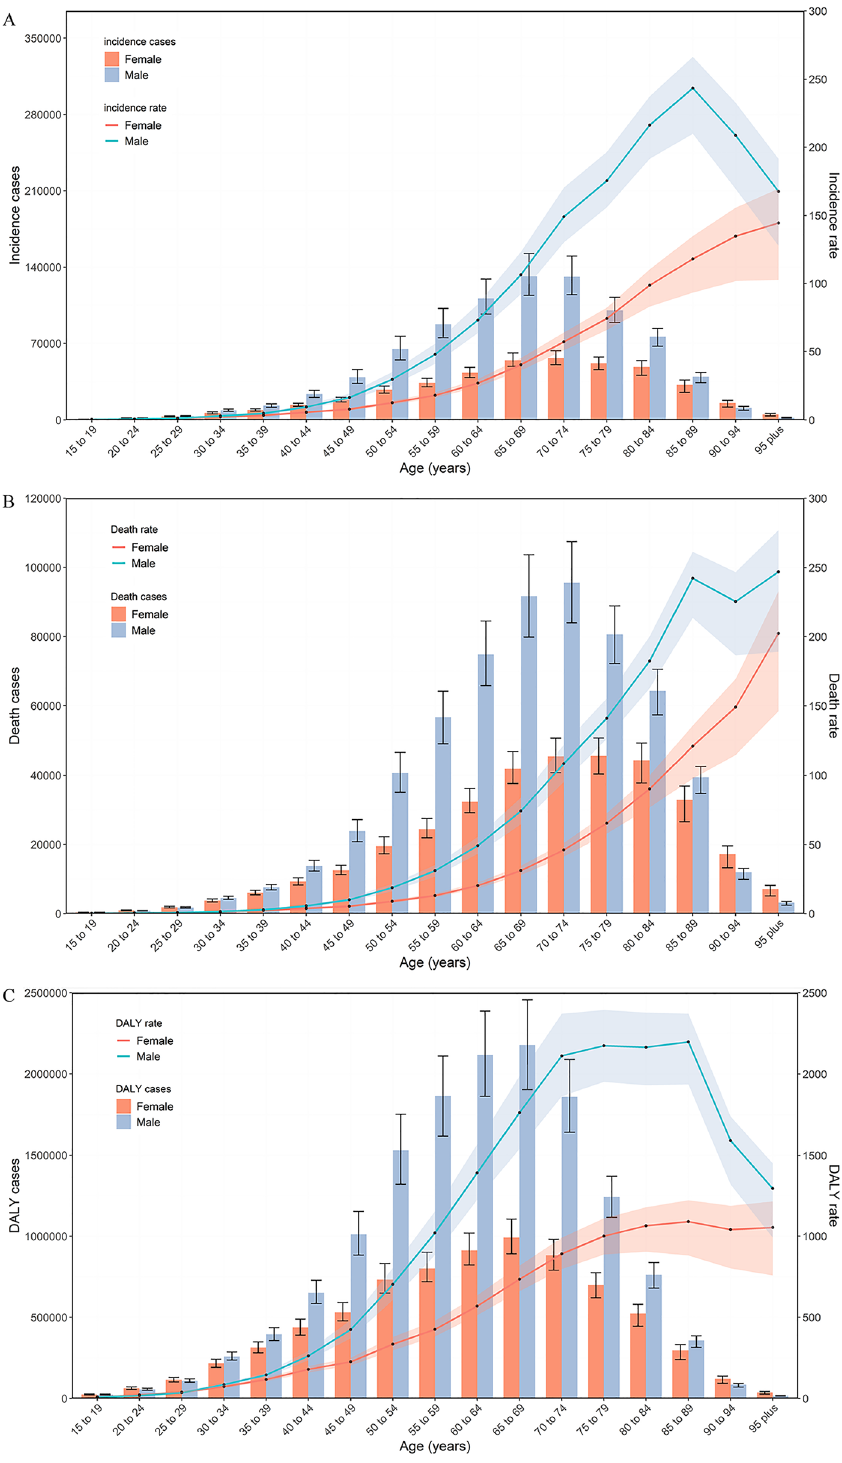
Figure 4. Global counts and age-standardized incidence ( A ), death ( B ) and DALY ( C ) rates of stomach cancer per 100,000 population by age and sex, 2019. Error bars indicate the 95% uncertainty intervals (95% UI) for incidence ( A ), death ( B ) and DALYs ( C ). Shading indicates the upper and lower limits of the 95% UI. DALY disability adjusted life